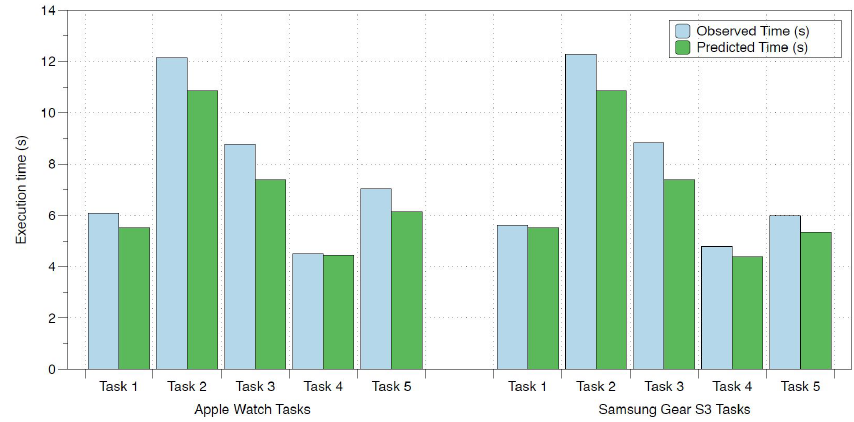
Figure 2. The average observed times and the predicted execution times for each of the five tasks for the two smartwatches (Apple Watch Series 3 and Samsung Gear S3). Table 7. Average observed time, predicted execution time, and calculated RMSPE for each of the ten experimental